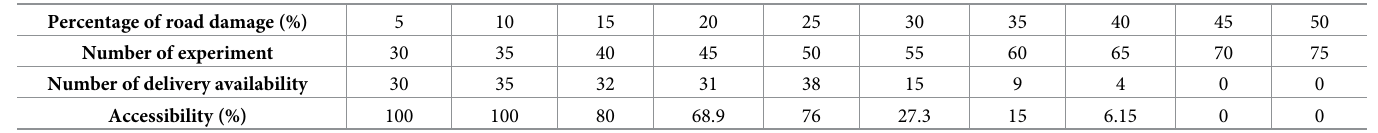
Table 18. Simulation tests of spatial accessibility of